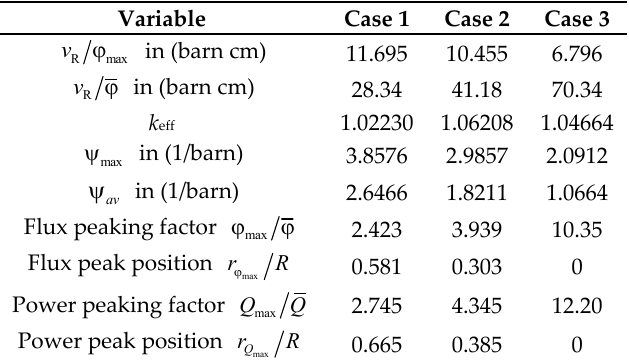
Table 3. Results of